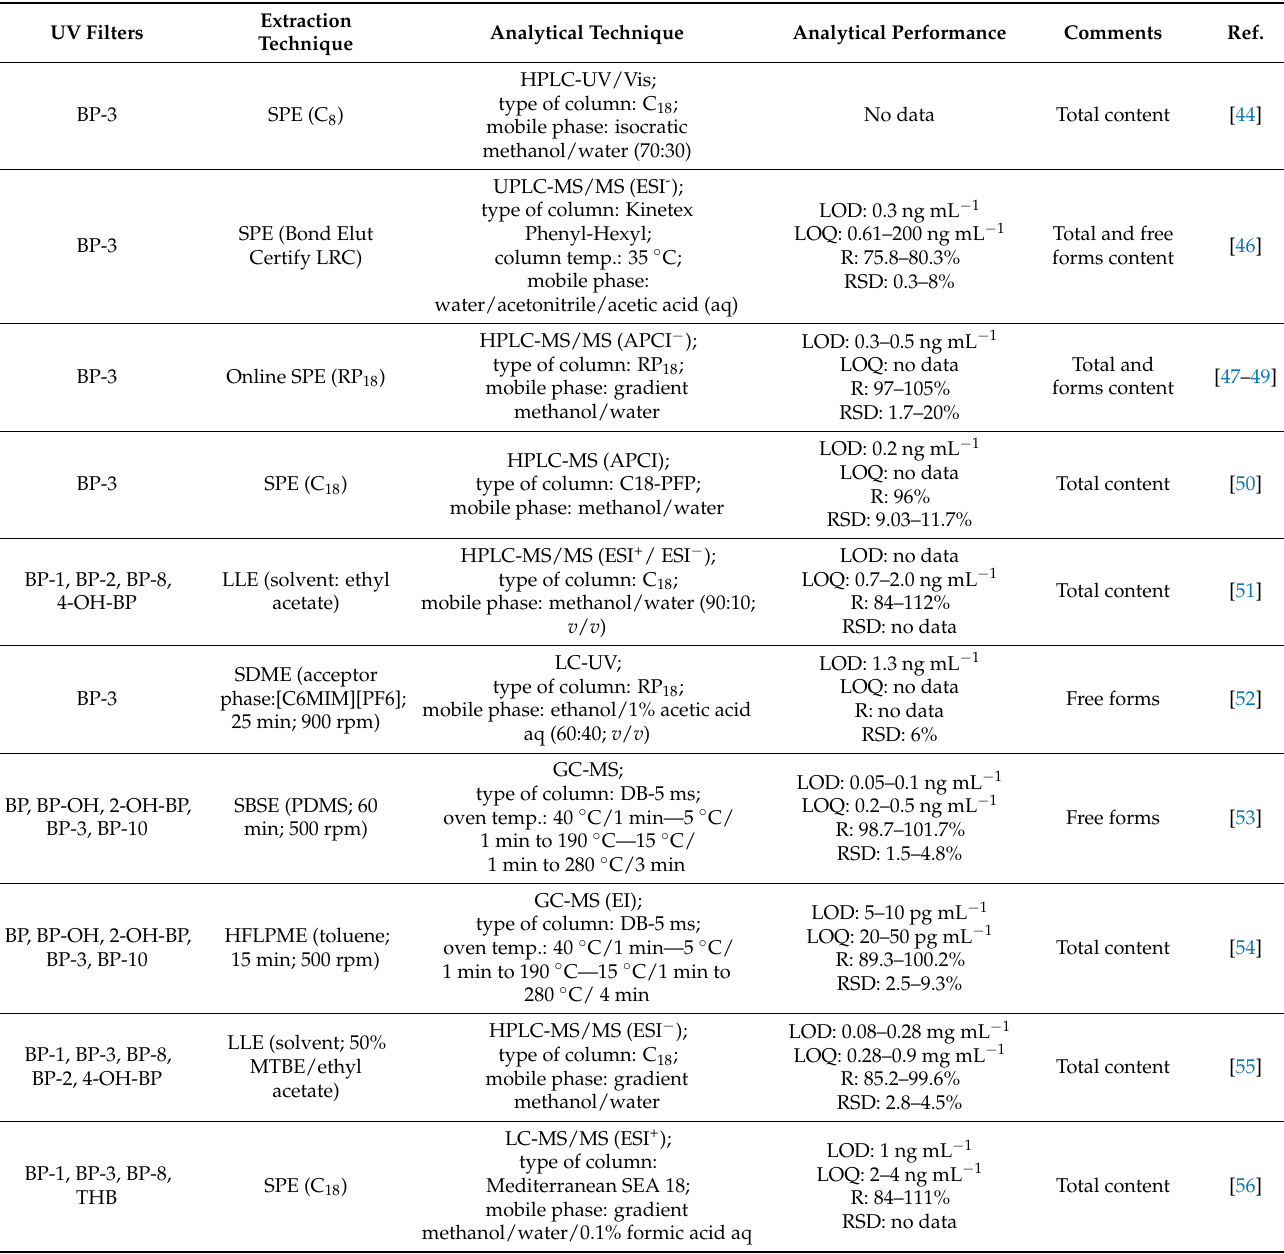
Table 3. Published papers on UV filters determination in